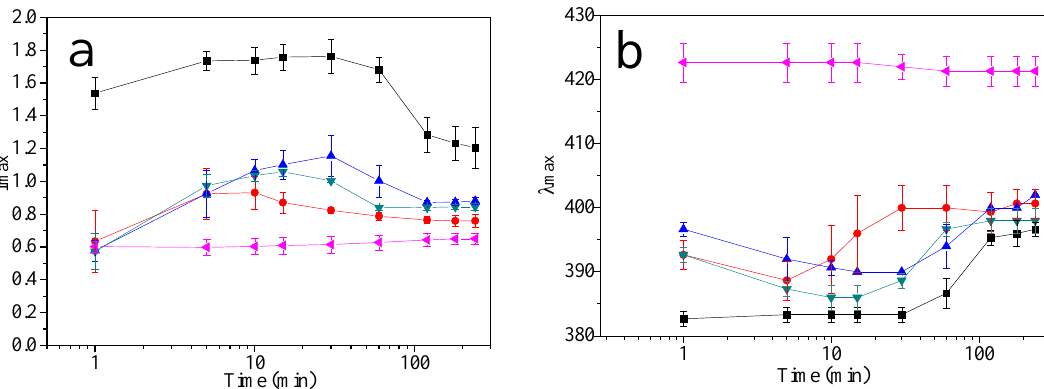
Figure 2. Semilog-plot of ( a ) I max and ( b ) λ max as a function of reaction time for AgNPs synthesized at 30 °C and different 30 ◦ C and different Pluronic P103 concentrations (wt%): ( (cid:4) ) AgNPs P103 0%; ( • ) AgNPs P103 0.01%; Pluronic P103 concentrations (wt%): ( ■ ) AgNPs P103 0%; ( ● ) AgNPs P103 0.01%; ( ▲ ) AgNPs P103 0.1%; ( ▼ ) AgNPs P103 0.5%, and ( ) AgNPs P103 1%. Solid lines are aids to the eye. Error bars indicate standard deviation for triplicate meas- ( (cid:78) ) AgNPs P103 0.1%; ( (cid:72) ) AgNPs P103 0.5%, and ( (cid:74) ) AgNPs P103 1%. Solid lines are aids to the eye. urements. Error bars indicate standard deviation for triplicate ◂